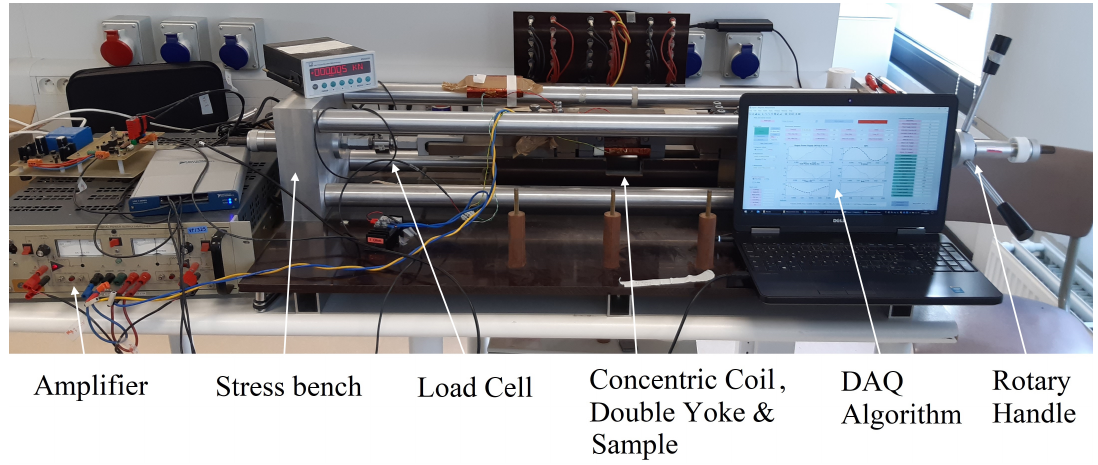
Figure 3. Experimental magnetomechanical setup used for magnetic measurements under external